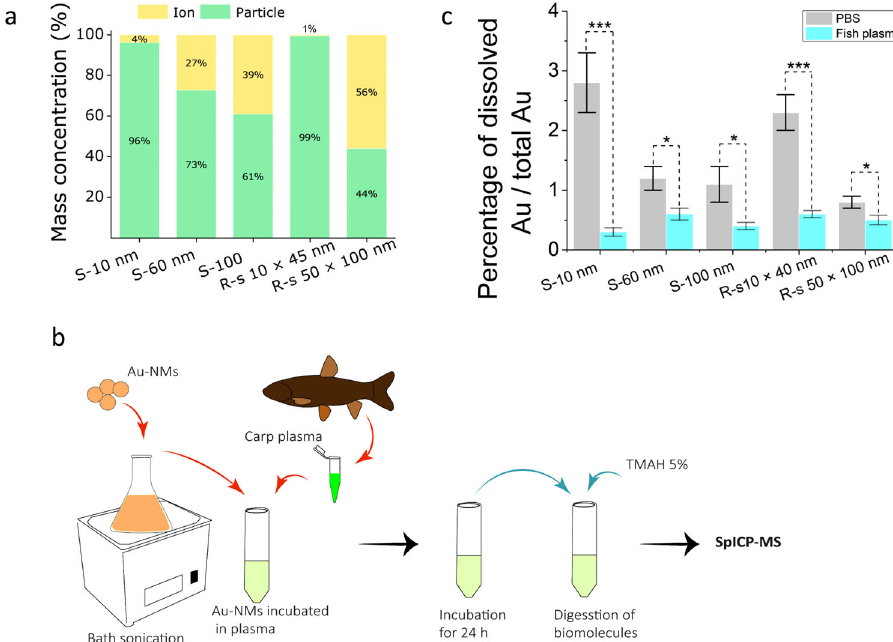
Fig. 2 Concentrations of gold nanomaterials (Au-NMs) and released Au + from the Au-NM. a Percentage of the intact particles (green) and Au ions (yellow) released from the Au-NMs in daphnids ( n = 5). The percentage was calculated by normalizing the mass of the particles or the mass of Au ions in daphnids to the total mass of Au in the daphnids. The graph shows that a higher percentage of dissolution in the daphnids occurred for the rod-shaped 50 × 100 nm followed by spherical 100 nm Au-NMs. S: spherical, R-s: rod-shaped. b Illustration of the incubation of Au-NMs in fi sh plasma extracted from adult carp. The Au-NMs were sonicated for 5 min and incubated in 10 times diluted fi sh plasma for 72 h. After incubation, the sample was digested with 5% Tetramethylammonium hydroxide (TMAH) and the concentration of the released ions was measured using single-particle inductively coupled mass spectrometry (spICP-MS). c Concentration of Au ions released from 10 mg mL − 1 Au-NM of different sizes and shapes after incubation in fi sh plasma for 72 h. One-way ANOVA with Duncan ’ s post hoc test were used to analyse the data (*** P < 0.0001; * P < 0.05). Error bars = SD ( n = 15), independent samples.